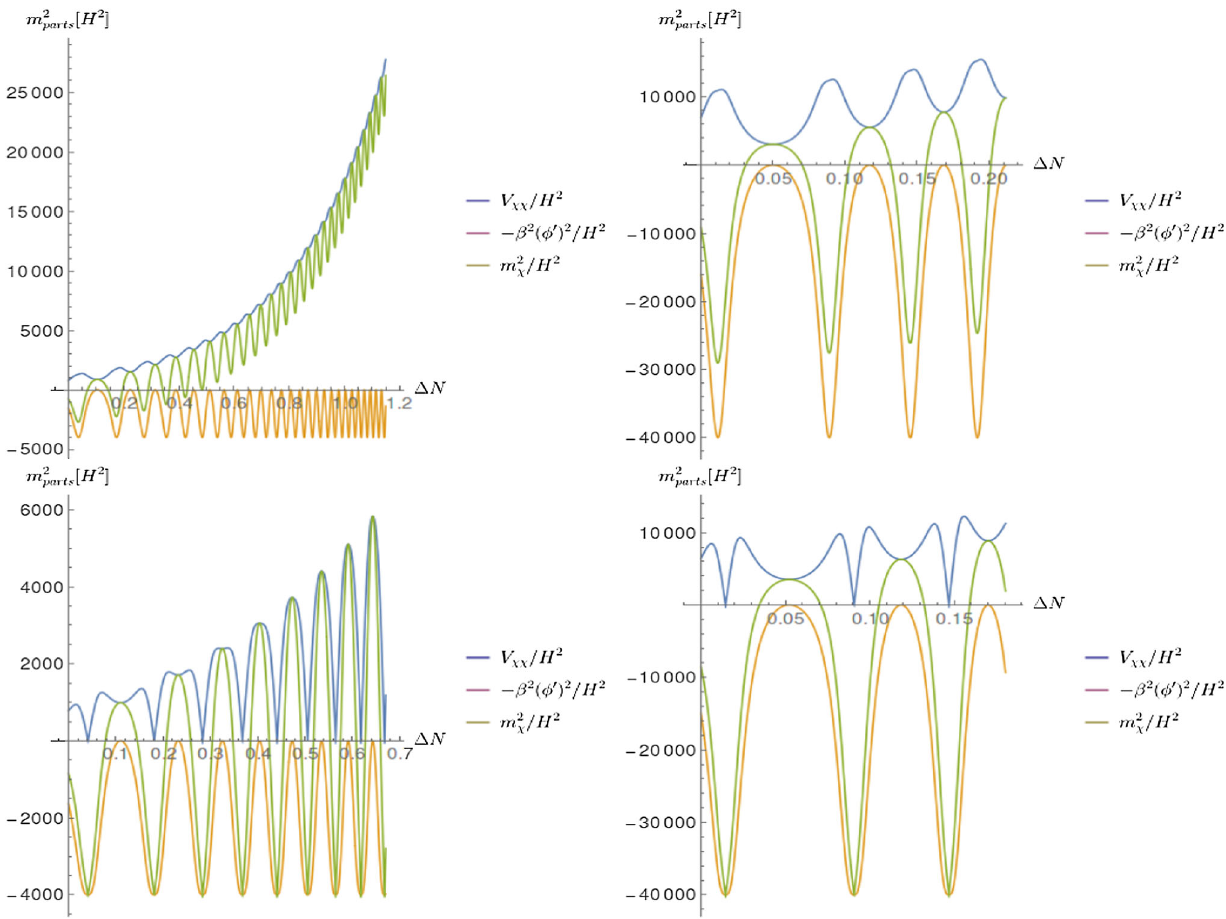
component and the geometrical component is also shown. Δ N is the number of efolds that elapsed after the end of